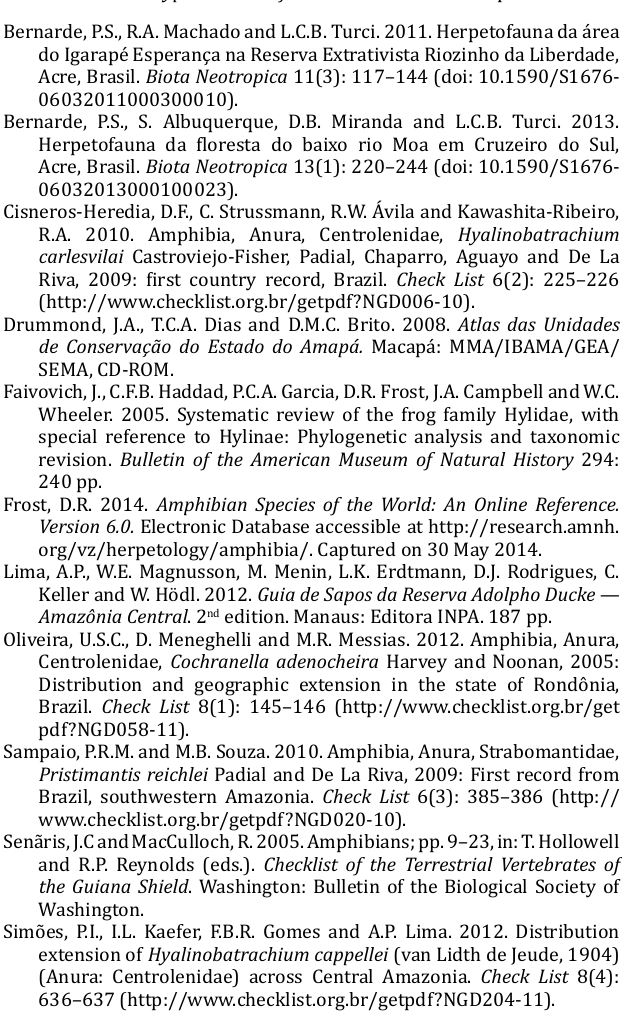
Figure 2. Map showing the recognized distribution of Ramos et al. 2010); the red circle the location of the new record and geographic distribution of